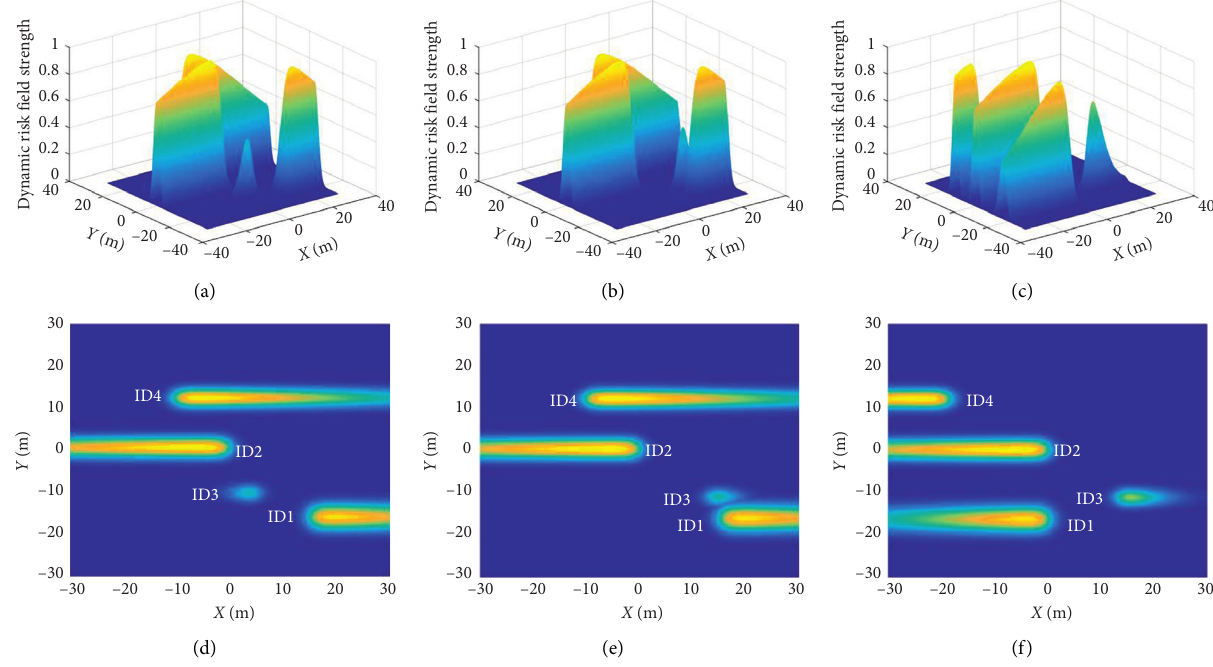
Figure 12: The changes of dynamic risk field prediction. (a) T � 1s. (b) T � 2s. (c) T � 3 s. (d) T � 1s. (e) T � 2s. (f) T � 3 s.